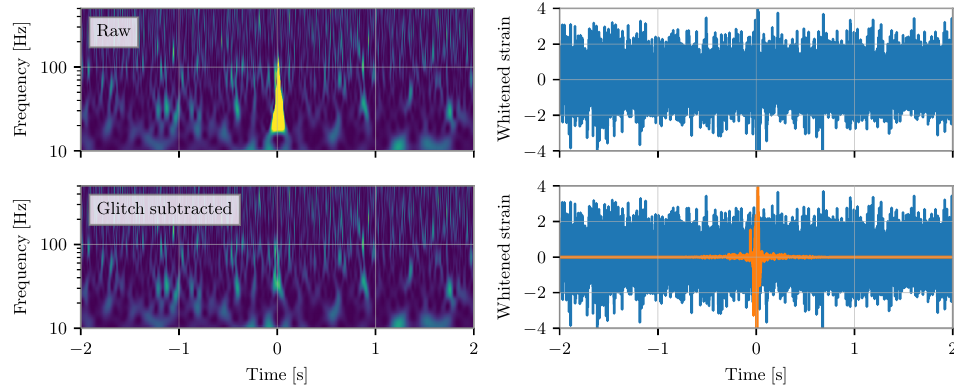
Figure 10. A demonstration of mitigating a glitch by modeling and subtracting the glitch with BayesWave [138–140]. eft column: Spectrograms of whitened strain data from the LIGO Livingston detector before and after subtraction of the glitch. Right column: Time series of the whitened strain before and after subtraction is plotted in blue, while the difference between the data before and after glitch subtraction is plotted in orange. After modeling and subtracting the glitch, the data are consistent with Gaussian noise. Plotted data are from